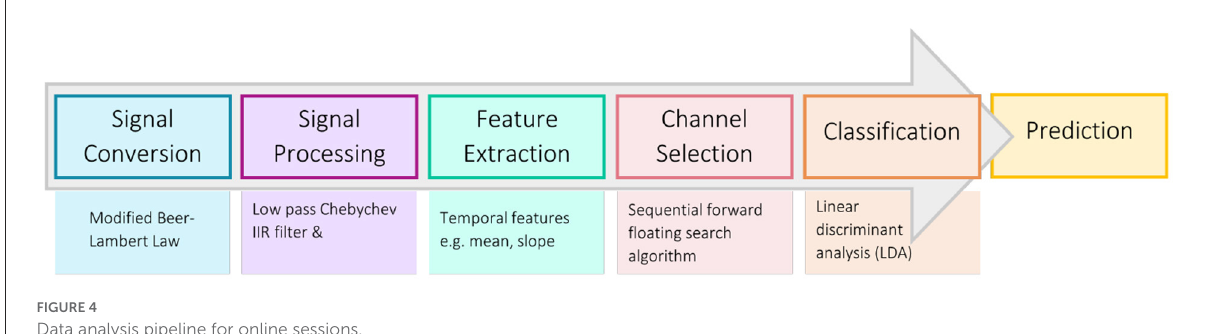
FIGURE4 Data analysis pipeline for online